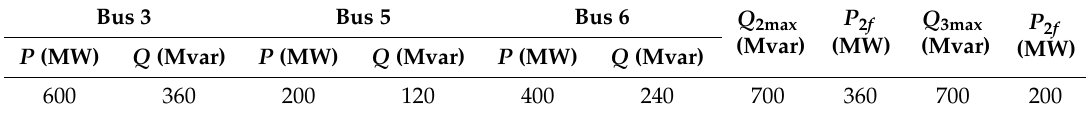
Table 1. Operating parameters for the six-bus test system.